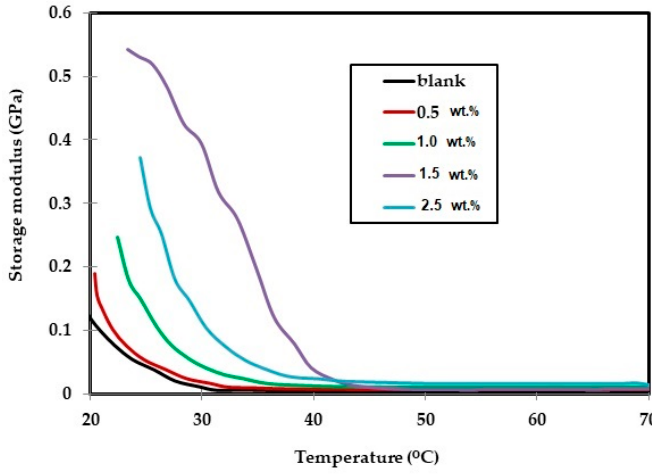
Figure 6. E ff ect of NPs loading on modulus of epoxy Figure 6. Effect of NPs loading on modulus of epoxy nanocomposites. Figure 6. Effect of NPs loading on modulus of epoxy nanocomposites.